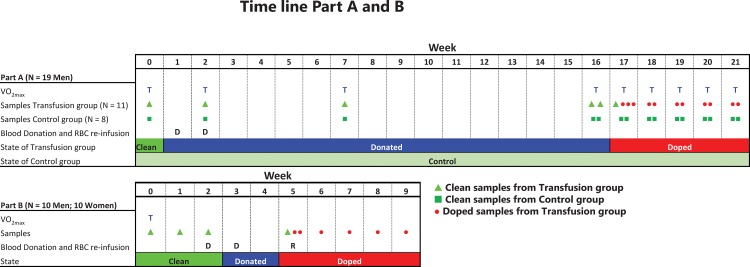
Time lines showing blood donation and re-infusion, blood sampling and VO2max testing from Part A of the Study and B of the study. In total, 19 men and ten women have participated, and 430 blood samples were taken (257 in Part A of the Study and 173 in Part B of the Study). D; Donation of one unit (450 mL) blood (for women in Part B of the Study at Week 3 only). R; Re-infusion of RBC. T; Testing of physical performance. ▲Clean samples from the Transfusion group; ■ Clean samples from Control group; ●Samples after RBC re-infusion.